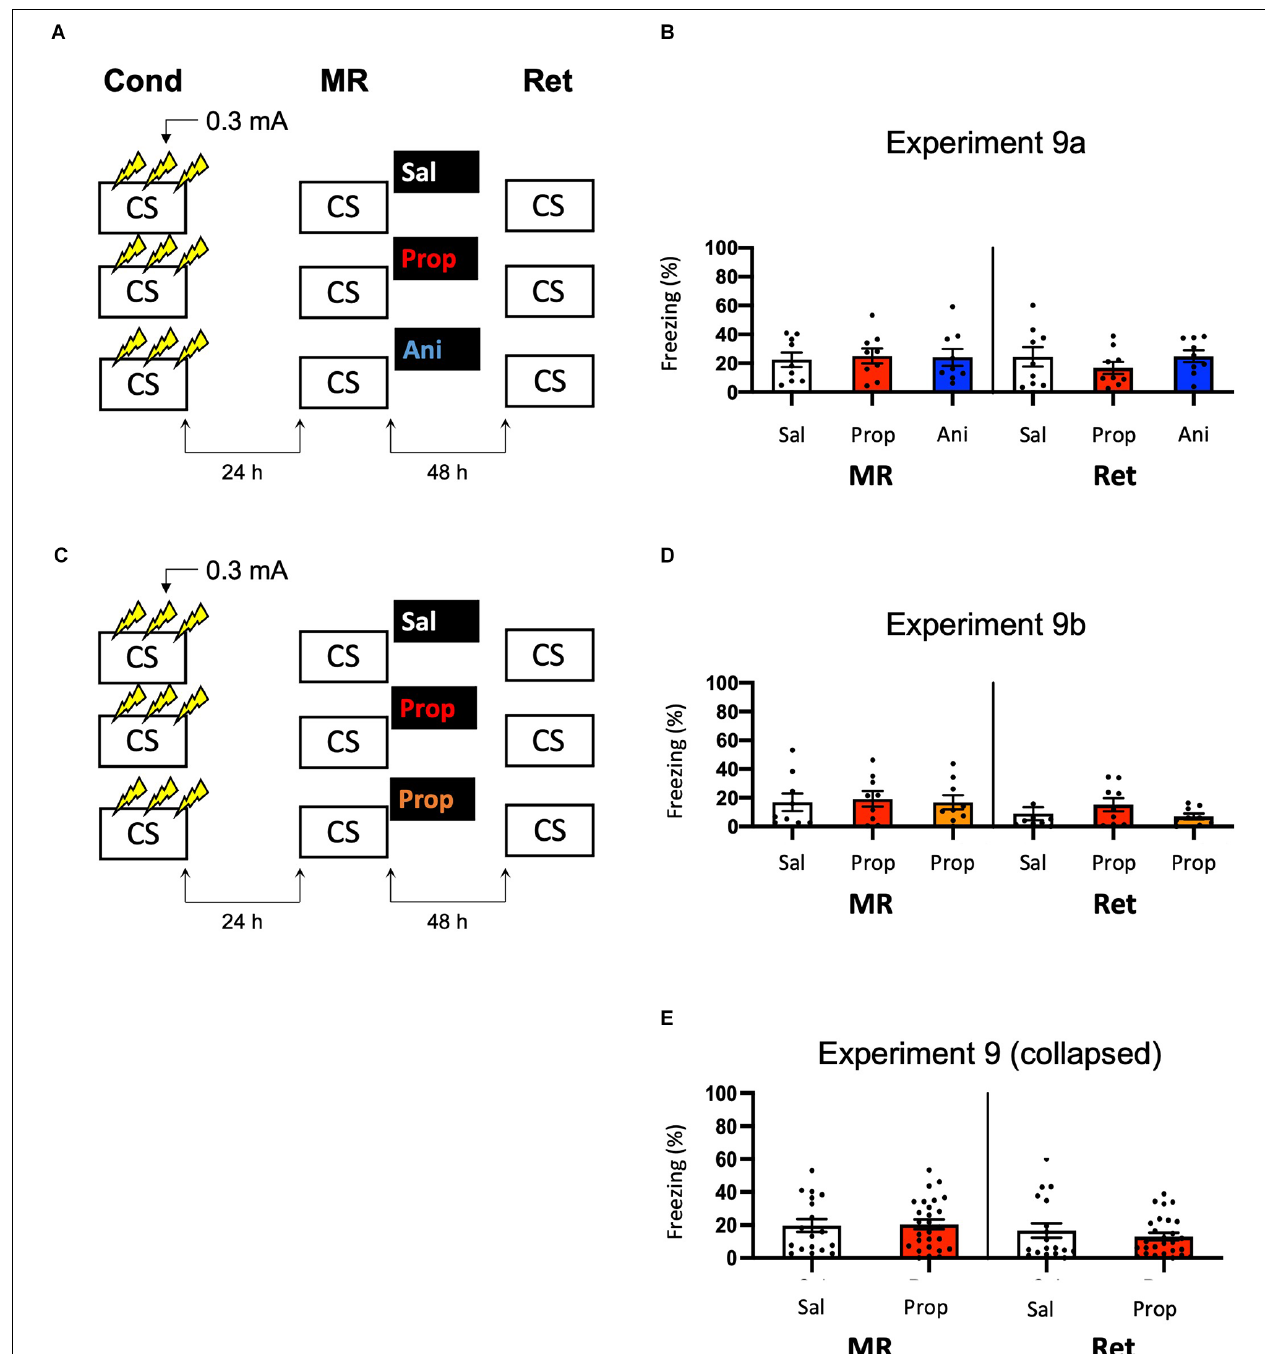
FIGURE 9 | No effect of propranolol or anisomycin on reactivated memories that were acquired with three 0.3 mA shocks during contextual fear conditioning. (A) Design of Experiment 9a. Mice received three 0.3 mA shocks during fear conditioning. One day later, mice received saline ( n = 9), propranolol ( n = 9), or anisomycin ( n = 9) after memory reactivation. Forty-eight hours afterward, retention of contextual fear was assessed. Cond, conditioning; MR, memory reactivation; Ret, retention; CS, conditioned stimulus (context); Sal, saline; Prop, propranolol; Ani, anisomycin. (B) Results of Experiment 9a. Average percentage of freezing during memory reactivation is displayed on the left, and freezing during the retention test on the right panel of the column chart (saline in white bars, propranolol in red bars, and anisomycin in blue bars). (C) Design of Experiment 9b. The anisomycin condition was replaced with propranolol dissolved in saline at half the usual ratio and injected in double the volume/body weight ( n = 9 in all conditions). All other procedures were the same as Experiment 9a. (D) Results of Experiment 9b (saline in white bars, propranolol in red bars, and propranolol double volume in orange bars). (E) Collapsed results of Experiment 9a and 9b (propranolol in all volumes). Error bars represent SEM. Filled circles indicate individual